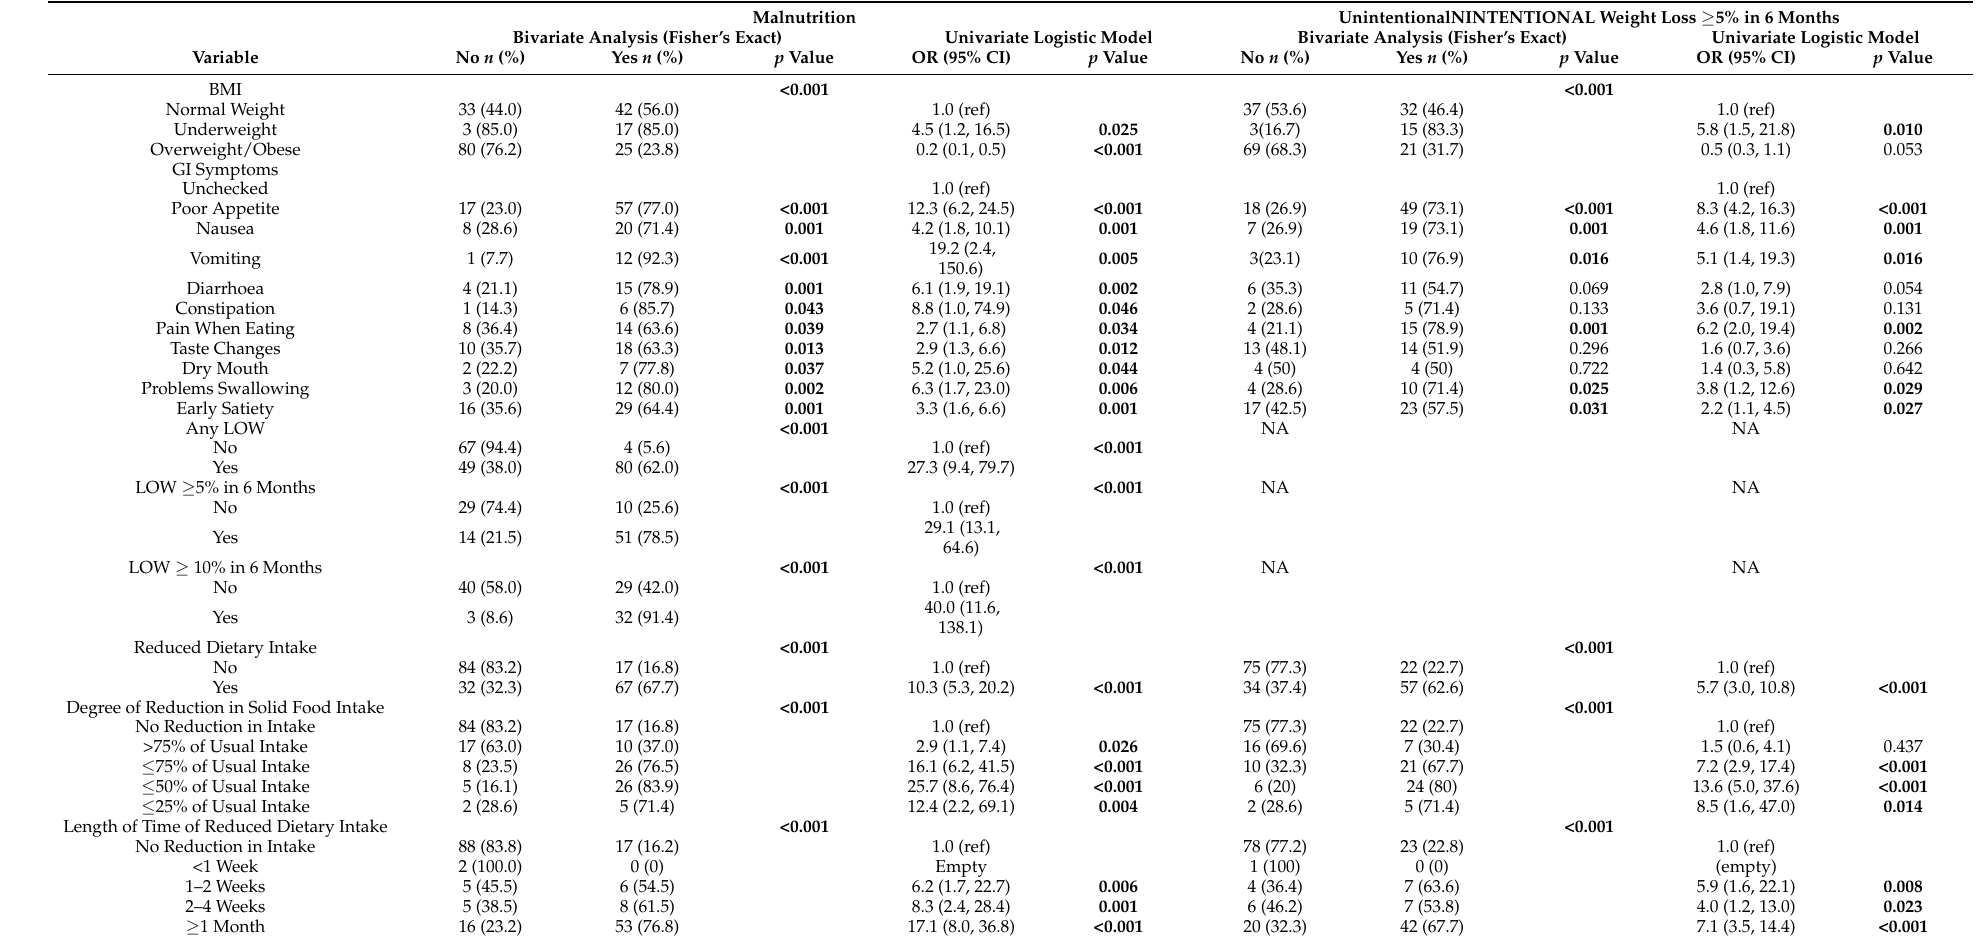
Table 4. Nutrition-related factors associated with malnutrition and clinically significant weight loss ( ≥ 5% in 6 months) prior to surgery ( n = 200).